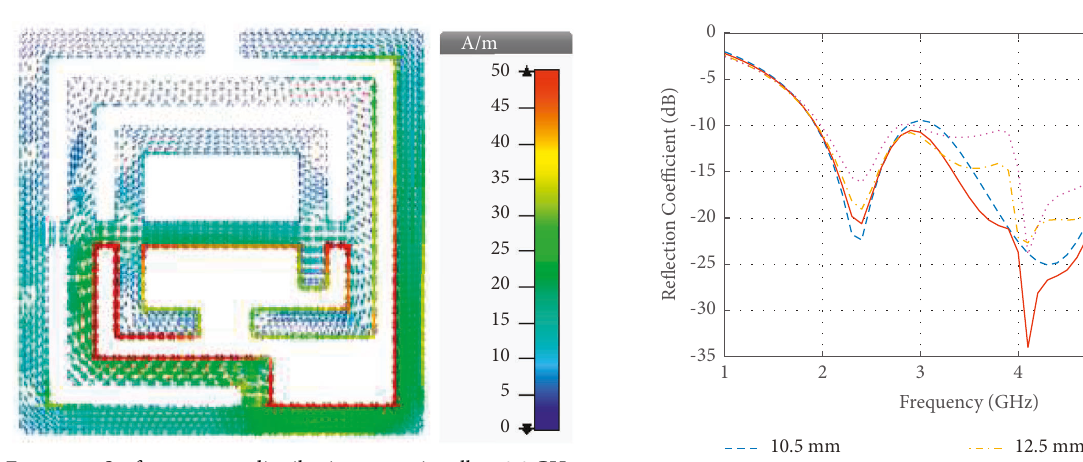
Figure 5: Surface current distribution on unit cell at 3.8GHz.